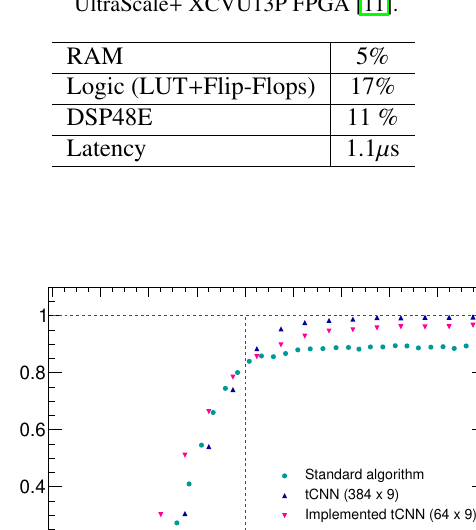
Table 1. A summary of the HLS resource occupation of the implemented tCNN on a Xilinx Virtex UltraScale + XCVU13P FPGA [11].